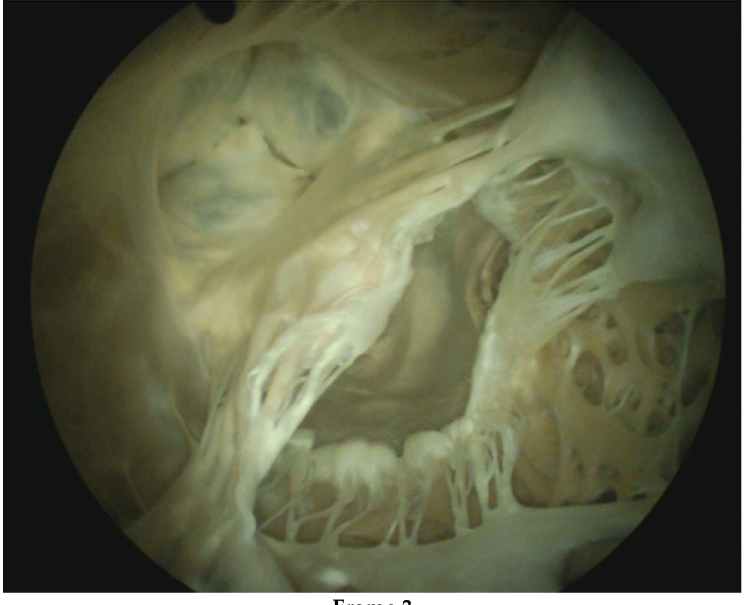
Figure 2. After thawing, the human cadaver heart is embalmed with a specialized solution of a very low toxicity. This embalmment ensures preservation, safe and user-friendly handling of the heart and tools and improves tissue quality, which allows for physiologic load of the heart, although protection measures always remain in place. Frame 1 . provides an external view of the embalmed human cadaver heart. Frame 2 . shows a TEE of the pulsating heart with an assessment of the diameter of the mitral valve diameter, the association with the aortic valve and length of chordae. Frame 3 . presents a still of the videoscopic presentation of the left ventricle and partial left atrium.